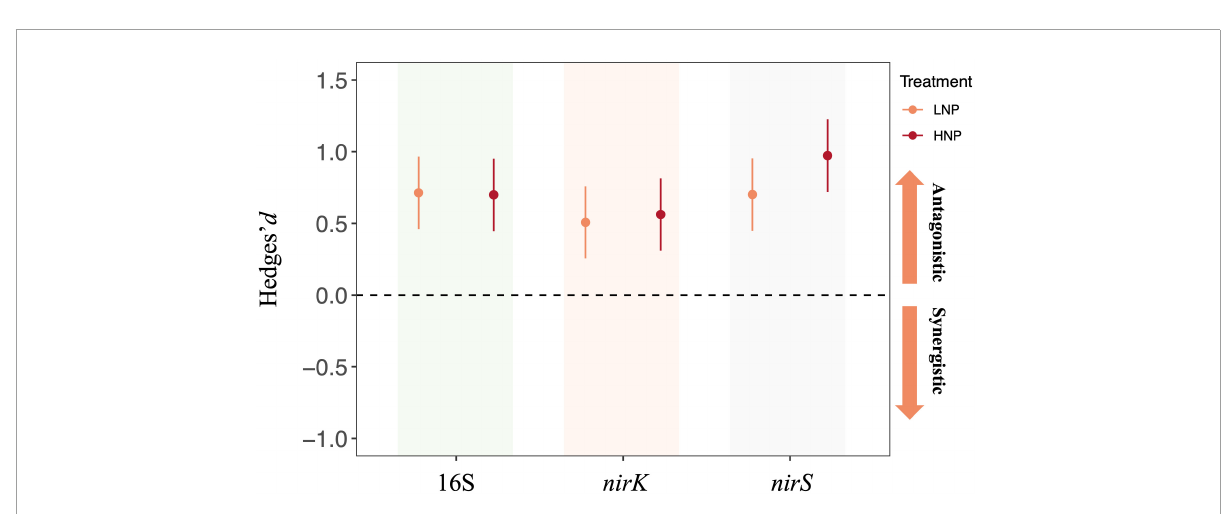
FIGURE6 Interactive effects of nitrogen (N) and phosphorus (P) addition on 16S, nirS , and nirK gene copy numbers. LNP, low N and low P; HNP, high N and high P. Error bars denote 95% confidence